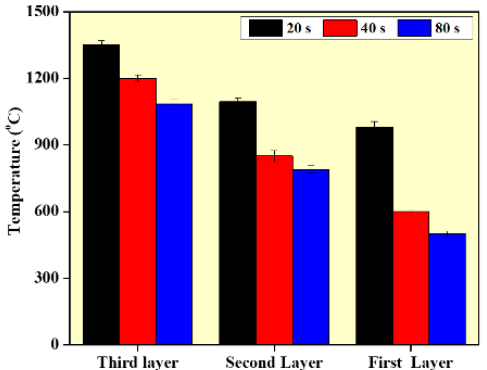
Figure 10. Temperature distribution in the WAAM samples according to the